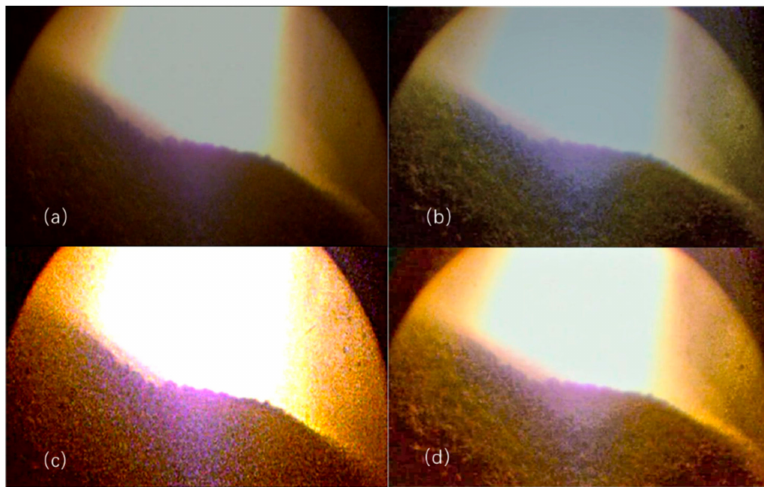
Figure 15. Origin images and clarity results by di ff erent methods. ( a ) Original image. ( b ) Result of histogram equalization method. ( c ) Result of retinex method. ( d )Result of our method.